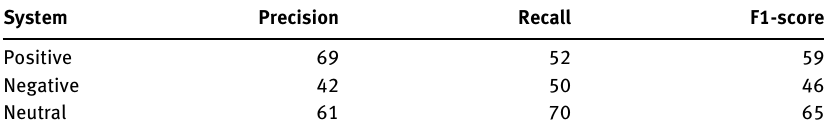
Table 5: Proposed Hybrid Approach Result on Test Data for Each Class.